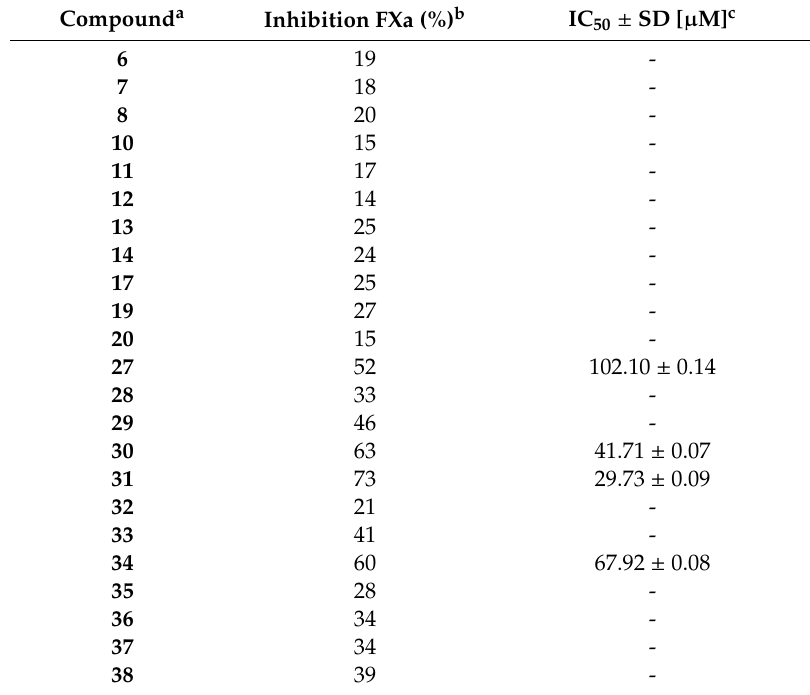
Table 9. FXa inhibition and IC 50 values of novel compounds 6 – 38 .